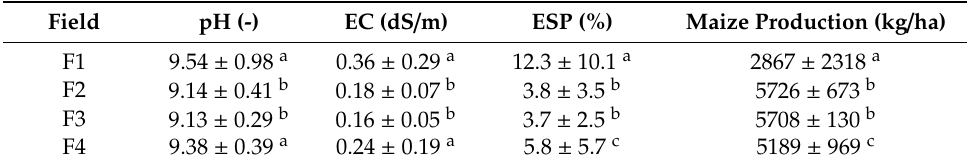
Table 4. Soil pH, EC, ESP, and maize production at the date of sowing in control plots (no soil amendments) of all experimental